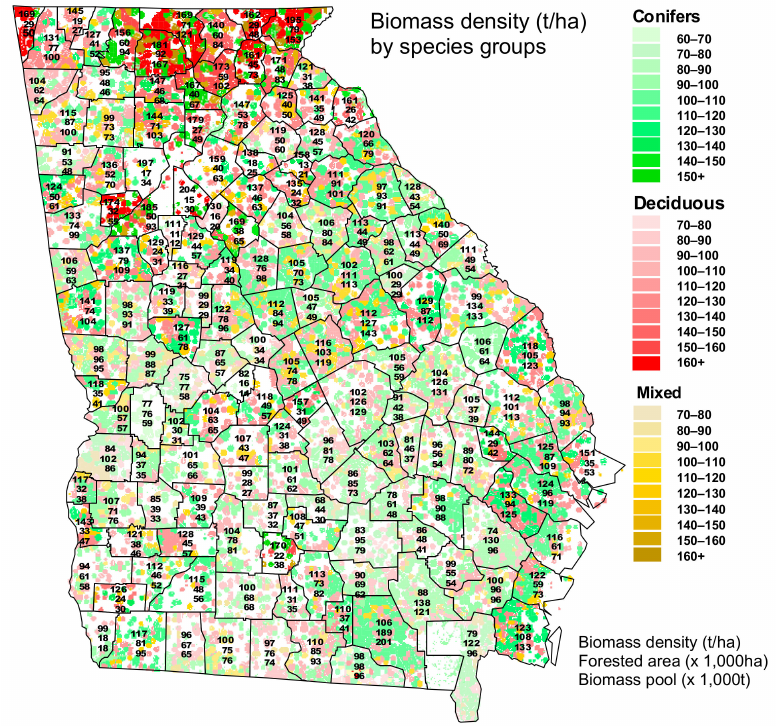
Figure 4. Biomass density, county areas and biomass pools on plot scale by forest types (coniferous, deciduous, and mixed) in